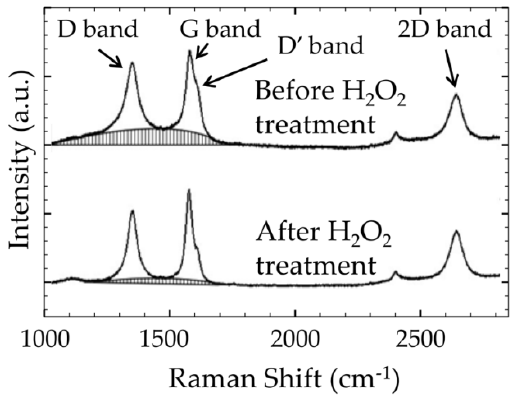
Figure 2. Raman spectra of nanographene before and after hydrogen peroxide treatment.